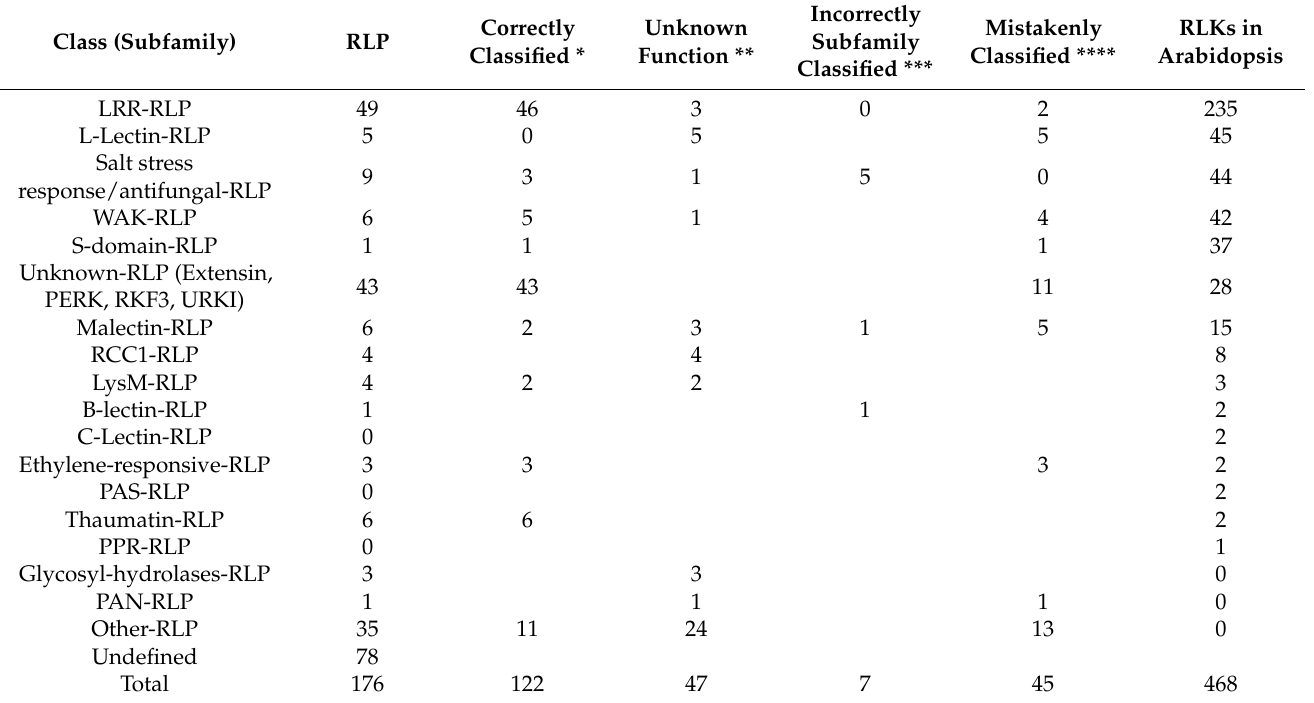
Table 9. Number of RLPs and predicted